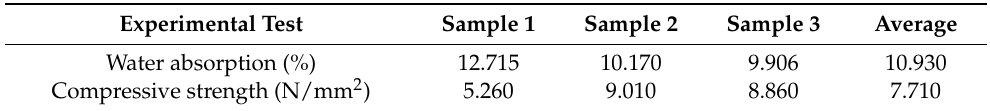
Table 5. Test results for conventional clay